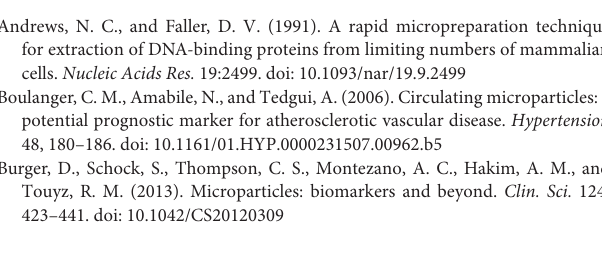
Data Supplementary Figure 1 | Representative images of the formation of vessels in the in vitro angiogenesis assay on the semi-natural matrix, Matrigel, 4h after seeding. (A) EPCs treated with EMV or (B) IsEMV, (C) Vascular endothelial growth factor (50ng/ml) used as a positive control, and (D) Endothelial basal medium (EBM) without fetal bovine serum (FBS) used as a negative control. Data Supplementary Figure 2 | Effect of various concentrations of IS ( µ g/ml) at different incubation times. Absolute number of MV per microliter in IS-treated and untreated HUVECs. (A) 6 h (B) 12 h, and (C) 24 h of incubation. Results are the mean ± SEM of five independent experiments. ∗ p < 0.001 vs. untreated HUVECs; # p = 0.002 vs. HUVECs + IS